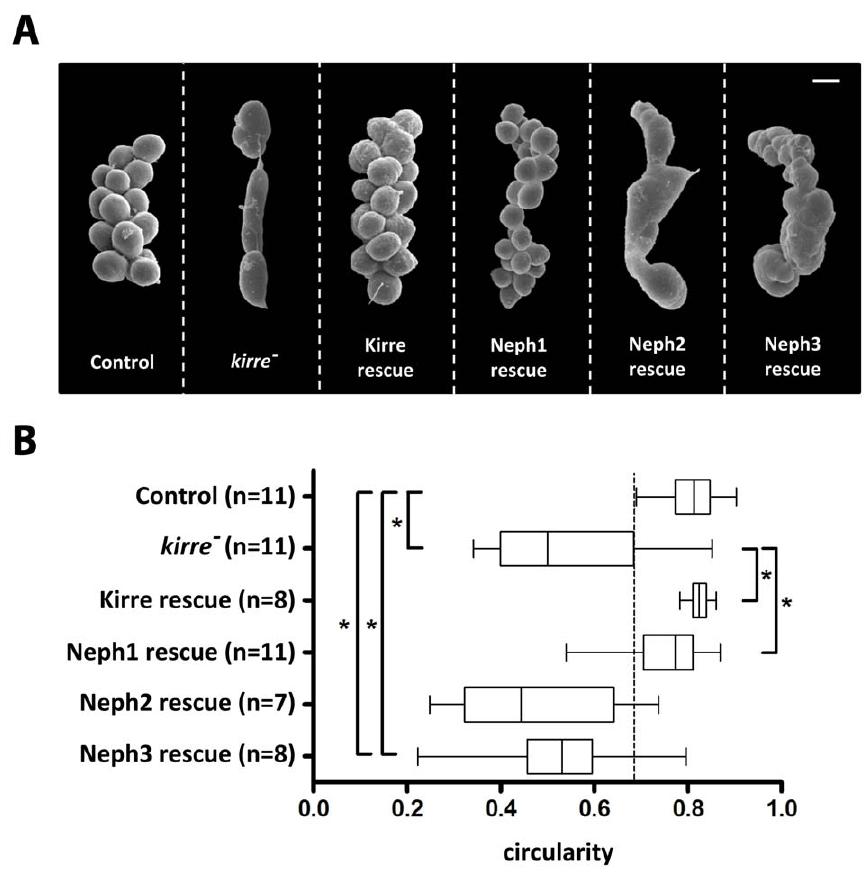
Figure 3. Third larval stage kirre - GCNs are hyperfused. Neph1 can rescue the kirre - phenotype. A. Scanning electron micrographs of GCNs at third larval stage. Scale bar: 20 m m. B. The fact that hyperfused GCNs lose their spherical shape was used to quantify the rescue efficiency. Kirre or Neph1 expression is sufficient to significantly rescue the kirre - phenotype. *P value , 0,0001 (unpaired t-test with Welchs correction). Genotypes: Control: + /sns-GAL4. kirre - : Df(1)duf sps-1 /y . Kirre rescue: Df(1)duf sps-1 /y; UAS-Kirre/sns-GAL4. Neph1 rescue: Df(1)duf sps-1 /y; UAS-neph1/sns- GAL4 . Neph2 rescue: Df(1)duf sps-1 /y; UAS-neph2/sns-GAL4 . Neph3 rescue: Df(1)duf sps-1 /y; UAS-neph3/sns-GAL4.